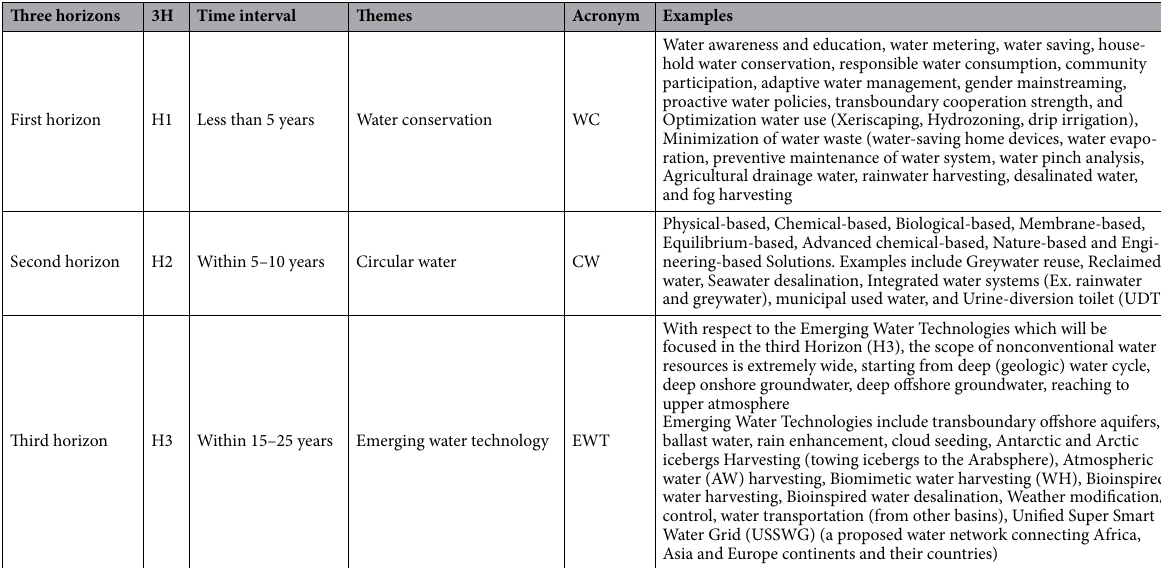
Table 5. Water vision based on three horizons in the Arabsphere.